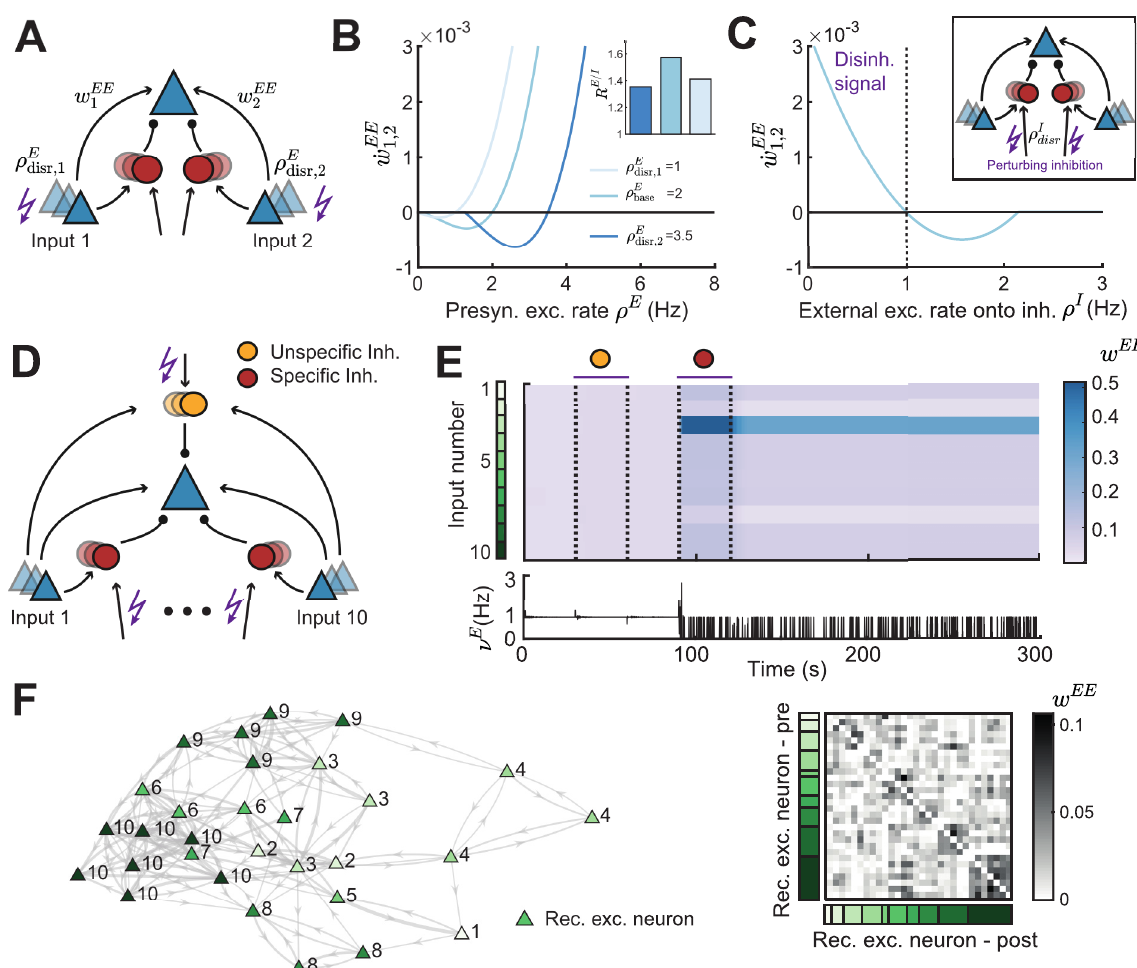
Fig 7. Gating of receptive field formation via a disinhibitory signal. A . Two independent inputs onto the same postsynaptic excitatory neuron. We perturb the presynaptic excitatory rate from input 1 or 2 ( r E ). B . Plasticity curve of E-to-E weights for input 1 or 2 ( _ w EE ) as a 1 ; 2 disr ; 1 ; 2 . Inset: E/I weight ratio R E / I for different input- function of the presynaptic excitatory rate ρ E for different input-specific perturbations r E disr ; 1 ; 2 specific perturbations. C . Plasticity curve of E-to-E weights for input 1 and 2 ( _ w EE ) as a function of the external excitatory rate onto the 1 ; 2 inhibitory neurons ρ I , corresponding to a perturbation r I of the inhibitory populations. Perturbing ρ I below 1 Hz (dashed line) is interpreted disr as a disinhibitory signal. Inset: We perturb the external excitatory rate onto the inhibitory neurons r I . D . Ten independent inputs onto the disr same postsynaptic excitatory neuron with one inhibitory population unspecific to the input (yellow) and ten inhibitory populations each specific to one input (red). E . Top: Evolution of excitatory weights over time. Purple bars indicate the time window where either the unspecific (yellow) or all specific (red) inhibitory populations is disinhibited by applying a negative input onto the inhibitory neurons (Methods). Input number color coded in green. Bottom: Postsynaptic firing rate ν E over time. F . Left: Network connectivity of recurrently connected excitatory neurons (triangles) after disinhibition. The number and the color indicates the input to which each neuron formed a receptive field (10 inputs in total). The thickness of the connection indicates the strength, only weights above 0.03 are shown. Distance and position of neurons is for visualization purposes only. Right: Ordered recurrent E-to-E connectivity matrix. Input number color coded in green as in panel E.